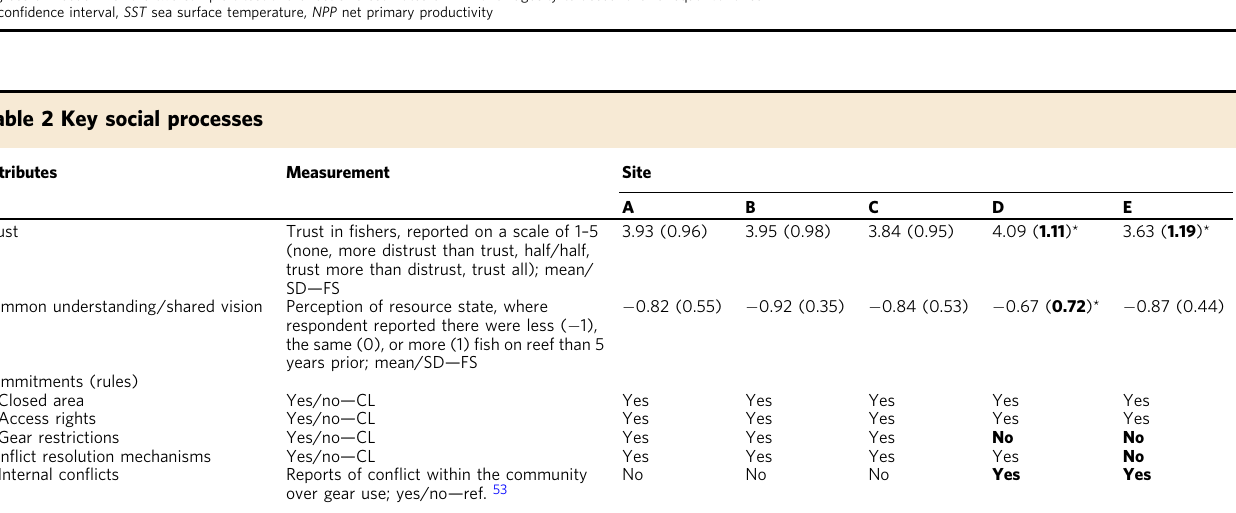
groups. FS fi sher survey, CL community leader interview